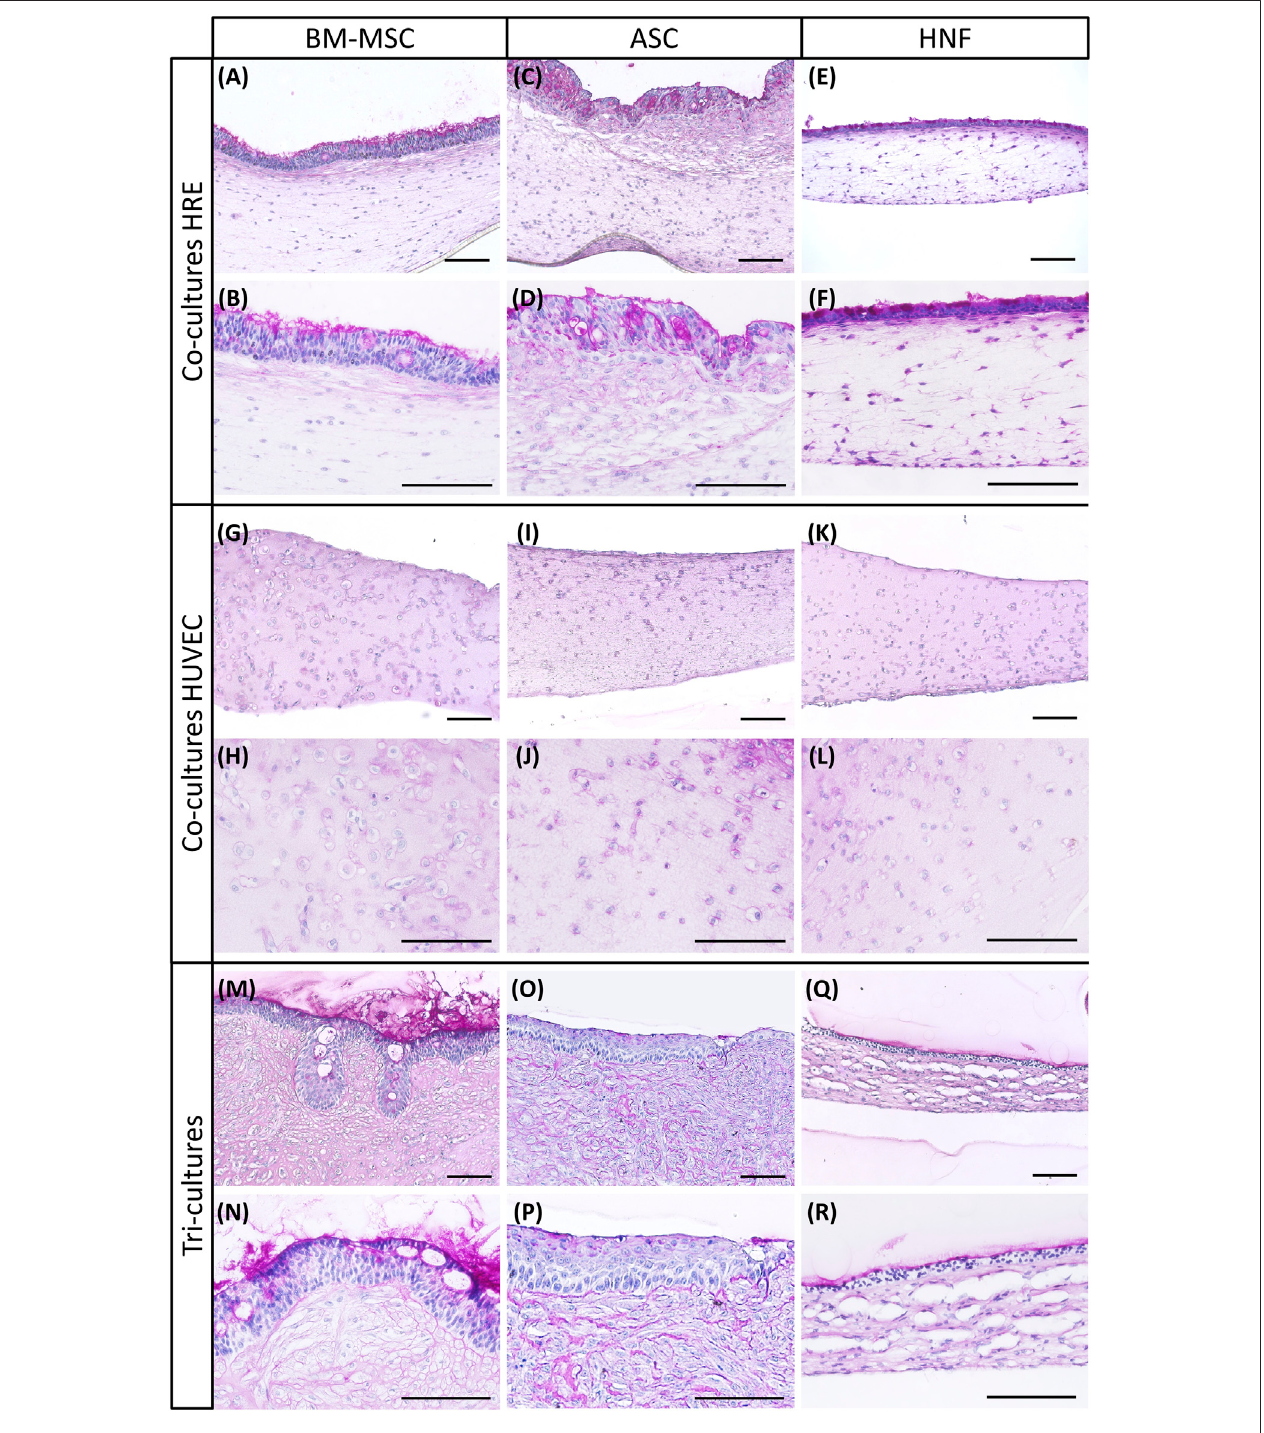
FIGURE 2 | PAS reaction of co-cultures with HRE, co-cultures with HUVEC and tri-cultures. (A – F) : PAS reaction revealed presence of glycogens, mucopolysaccharidesandglycoproteinsinco-culturesofHREwithdifferentsupportingcelltypes:BM-MSC (A,B) ,ASC (C,D )orHNF (E,F)(G – L) :PASreactionshowed overall morphology of fi brin gels containing HUVEC and varying supporting cell types in co-culture: BM-MSC (G,H) , ASC (I,J) or HNF (K,L) (M – R) : PAS reaction indicated near native morphology of the respiratory epithelium in tri-cultures with BM-MSC (M,N) while using ASC (O,P) or HNF (Q,R) led to cell multilayers with reduced mucociliary differentiation. Representative pictures of two different magni fi cations are shown. Scale bar: 100 µm.